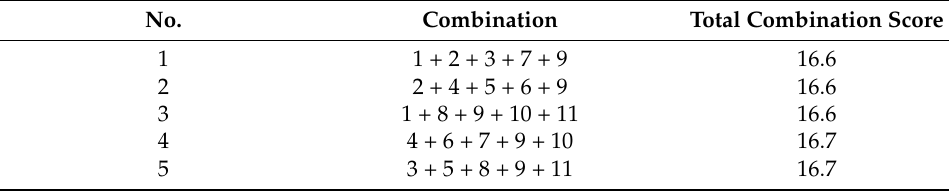
Table 12. List of combined features with their respective total